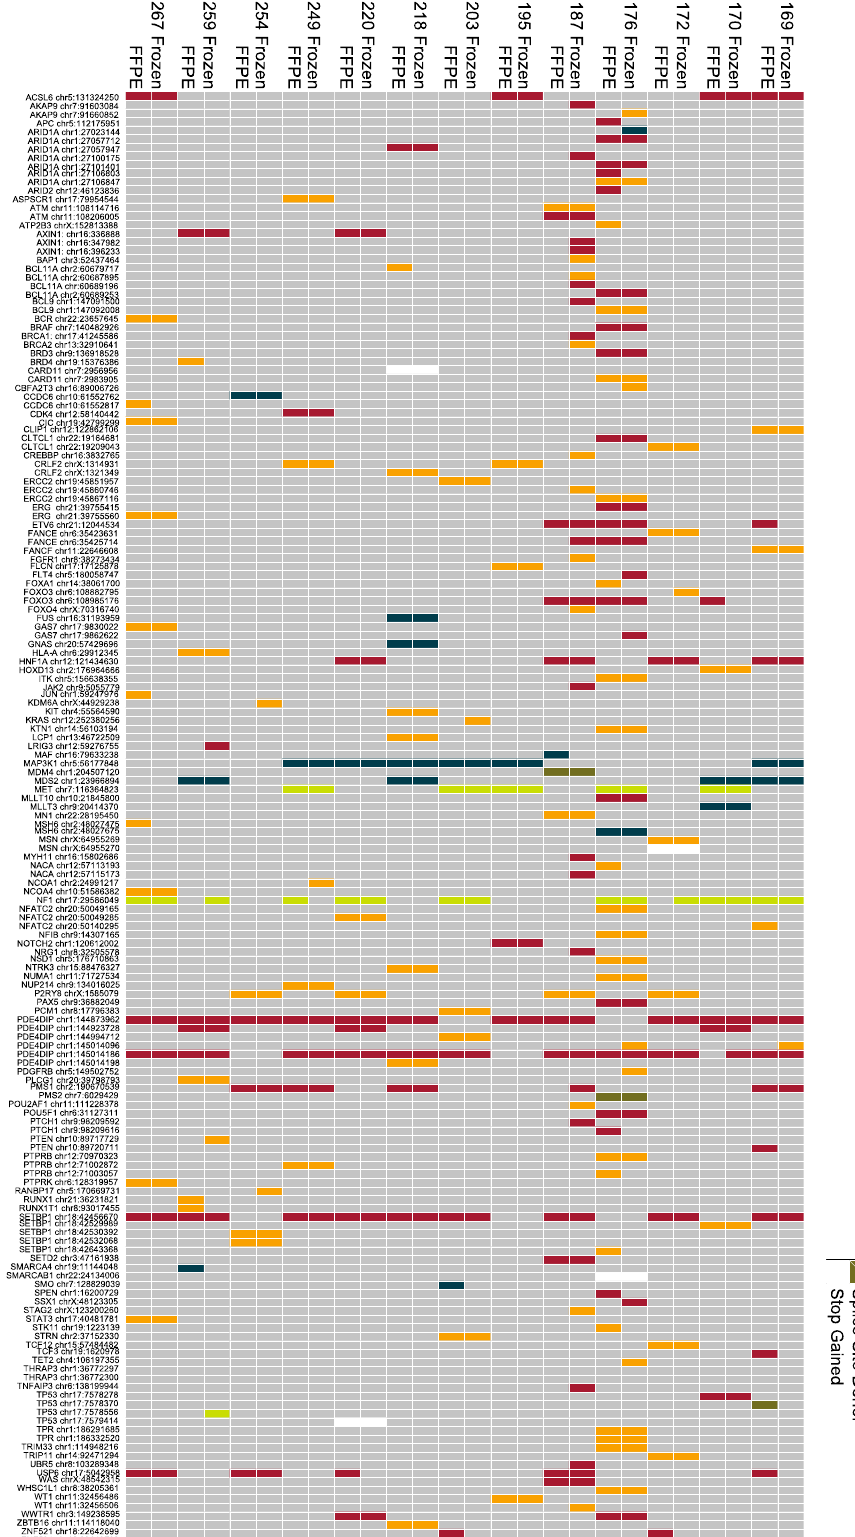
Figure 2. Detection of cancer-related genes from exome sequencing of gastro-oesophageal tumour DNA. Commutation plot showing the presence of mutations in genes from the Cancer Genome Census from exome sequencing of DNA extracted from frozen and formalin-fixed paraffin-embedded (FFPE) oesophageal tumours.